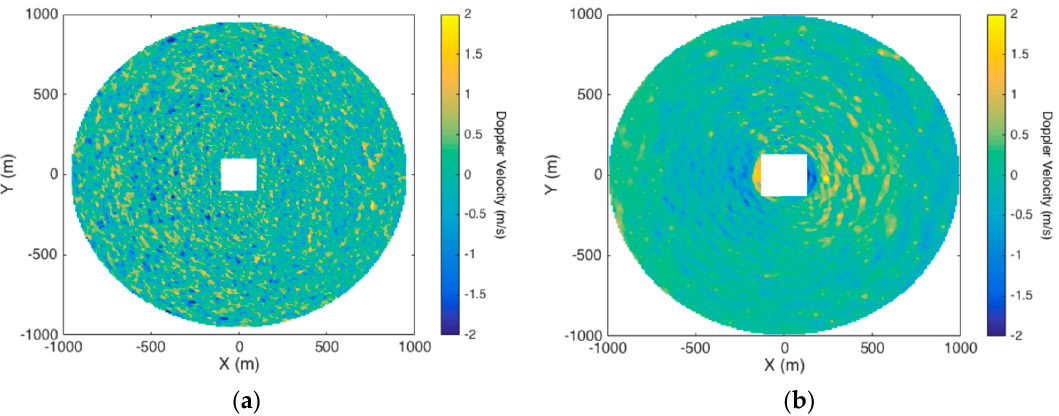
Figure 1. Sample Doppler velocity distributions measured by ( a ) the UM radar and ( b ) the APS radar. These Doppler distributions are from dataset 9 for both systems (see Table 2 for details on the environmental conditions). Also note that each frame has been rotated such that the peak wave propagation direction is oriented along the x -axis.